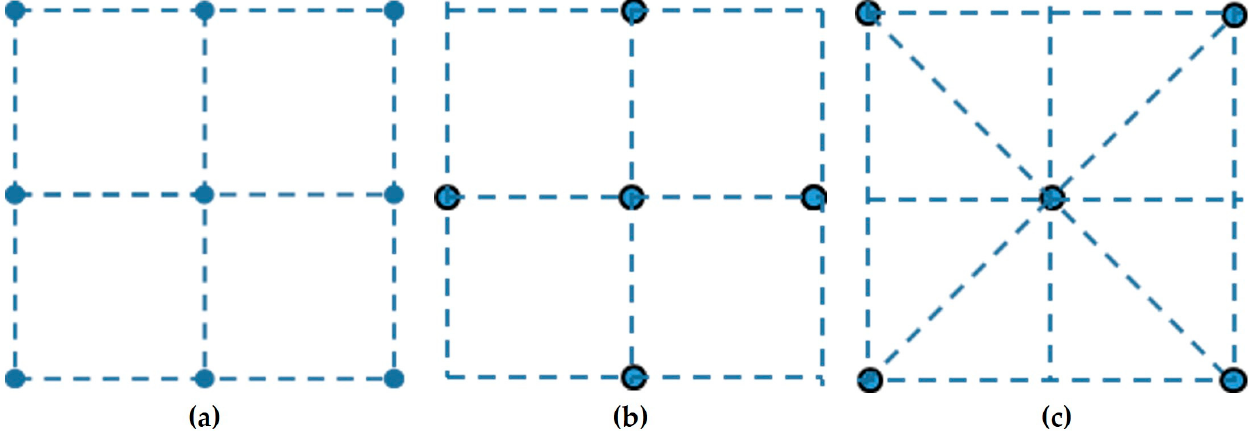
Figure 3. Schematic diagram of the experimental model: ( a ) schematic diagram of the particle distribution, ( b ) schematic diagram of the bending spring, and ( c ) schematic diagram of the reinforcing spring.